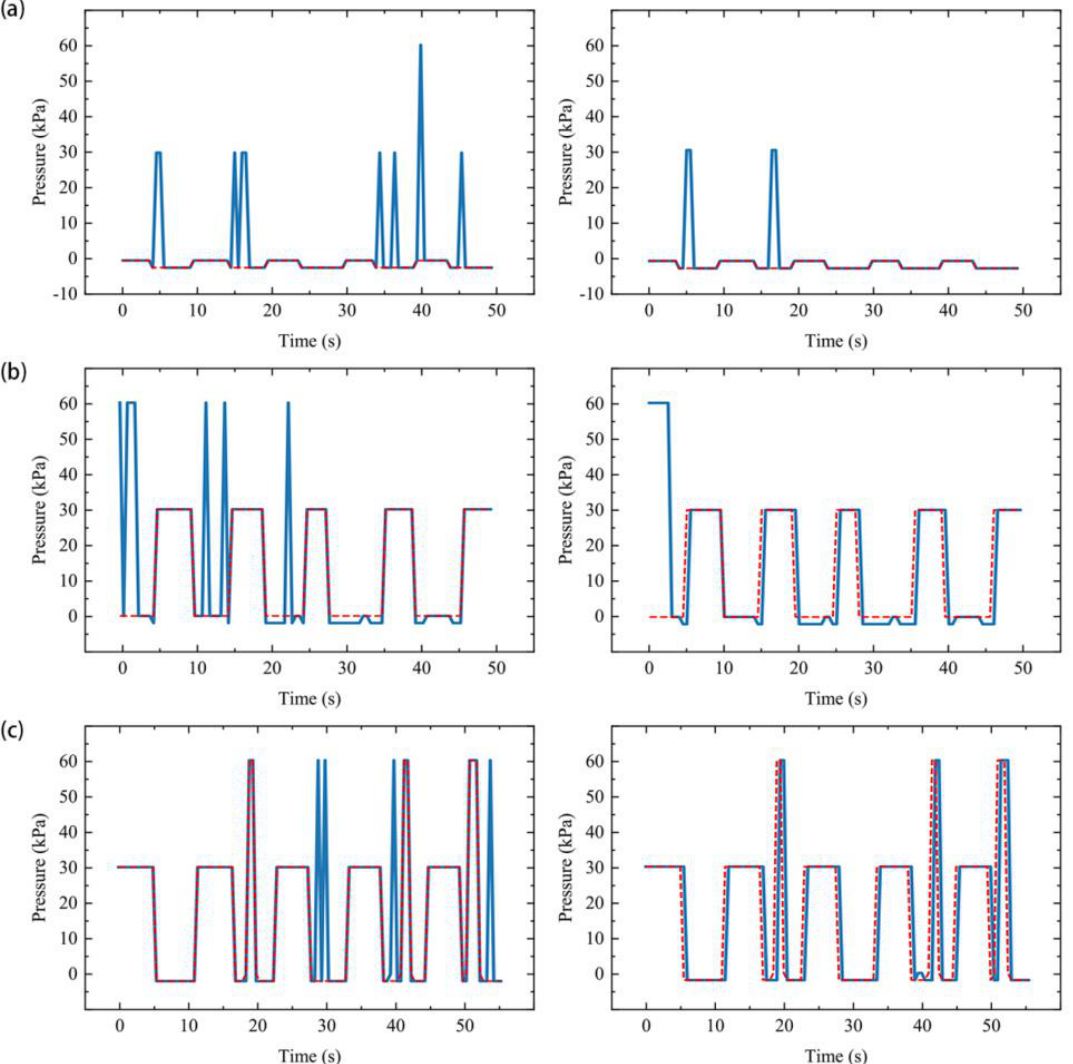
Figure 14. The pressure values transformed from the model prediction of the three motion sequences. The left graphs show the results after the neural network model (blue lines); the right graphs show the results after the state exclusion (blue lines). The red lines show the ground truth pressure values. ( a ) The results for motion sequence RE. ( b ) The results for motion sequence RS. ( c ) The results for motion sequence SF.